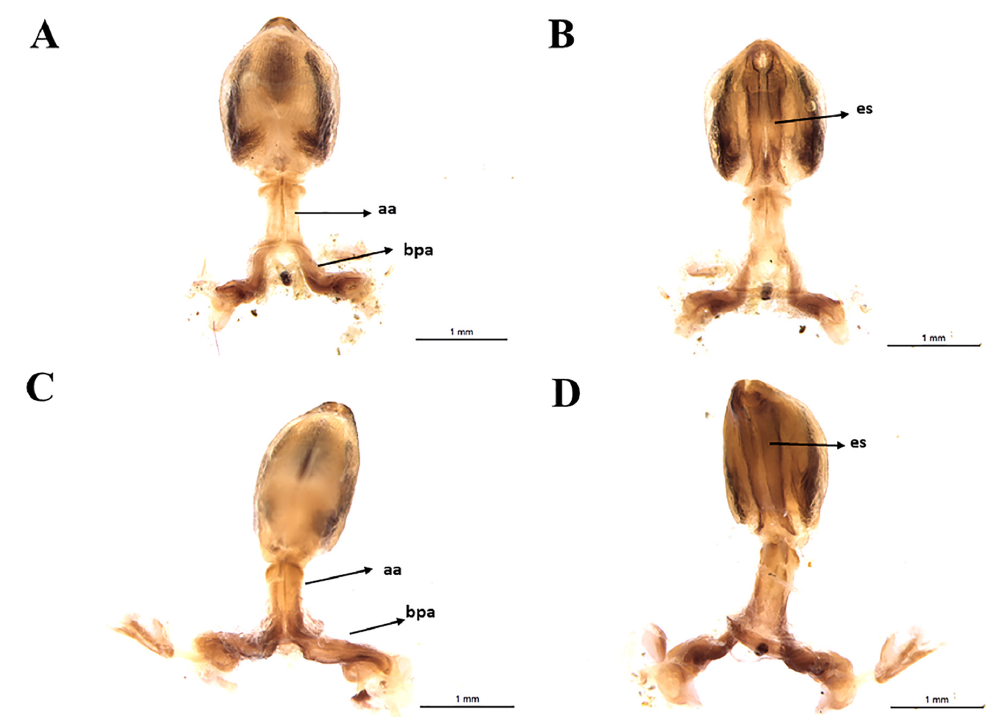
Figure 8. Phallus of T. rosai sp. nov.: ( A ) dorsal view, ( B ) ventral view, T. sordida : ( C ) dorsal view, ( D ) ventral view. bpa: basal plate arm, aa: articulatory apparatus, es: endosomal struts.